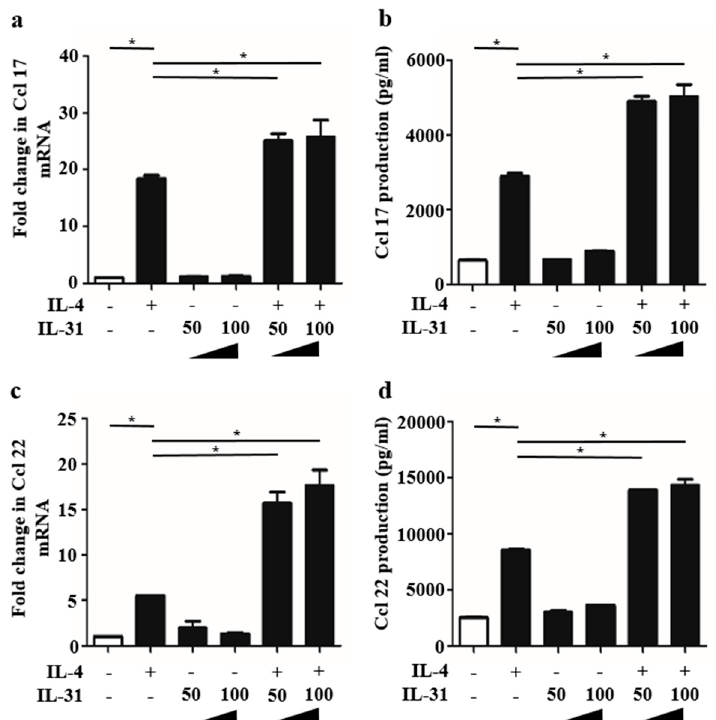
Figure 2. IL-31 stimulation enhanced IL-4-induced Ccl 17 and Ccl 22 production in BMDCs. ( a – d ) Data are expressed as mean ± standard error of the mean (S.E.M.); n = 3 for each group; * p < 0.05. Expression of Ccl 17 (a) and Ccl 22 (c) mRNA in BMDCs stimulated with or without IL-4 (10 ng / mL) and IL-31 (50 and 100 ng / mL) for 48 h and production of Ccl 17 (b) and Ccl 22 (d) in the culture supernatant were measured.